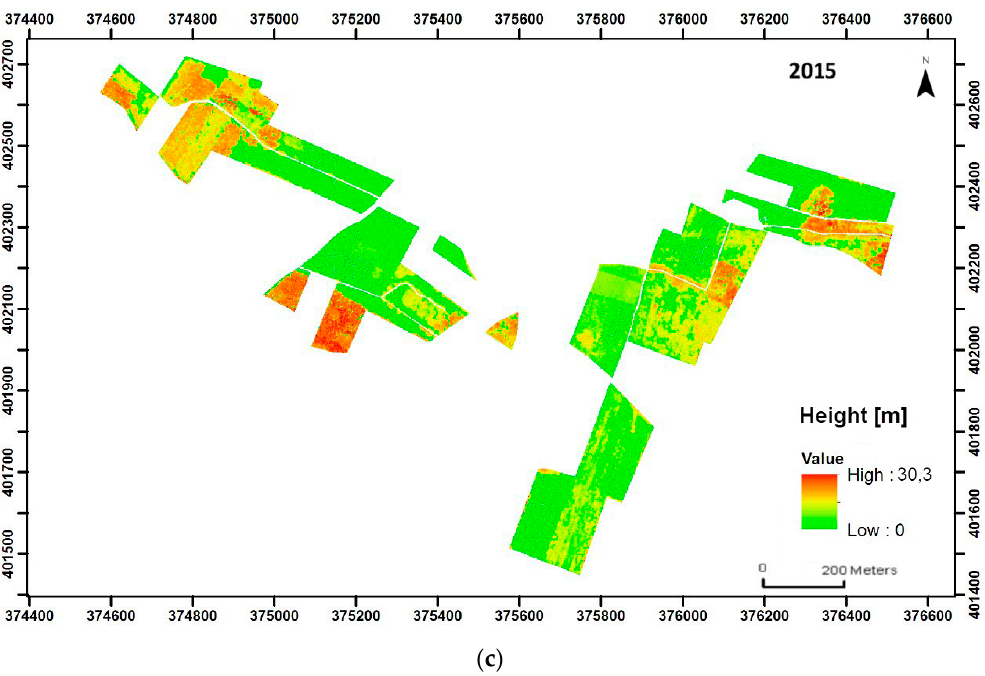
Figure 6. Vegetation parameters—height of vegetation (95th percentile): ( a ) 2007; ( b ) 2012; ( c ) 2015.